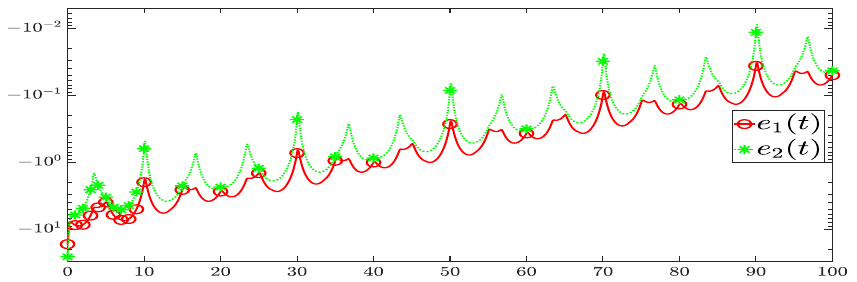
Figure 6. The corresponding error trajectories of system (1).